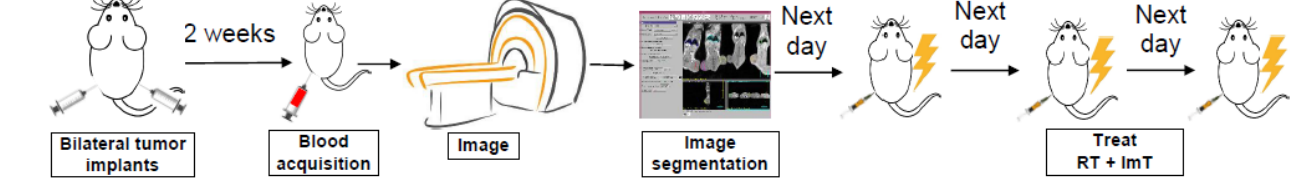
Figure 1. Study design: From left to right—bilateral tumors are implanted and 1–2 weeks later (tumor volumes ~200 mm 3 ), blood is acquired, animals are CT- and MR-imaged, image segmentation is performed, and RT + ICI is started on the day after imaging. RT is delivered for three consecutive days. On each treatment day, tumors are irradiated with 8 Gy followed by PD-1 is administered through intraperitoneal injection. After tumor volumes reach the maximum allowed size, the animals are sacrificed, and lung tissue is acquired for immunohistochemistry.